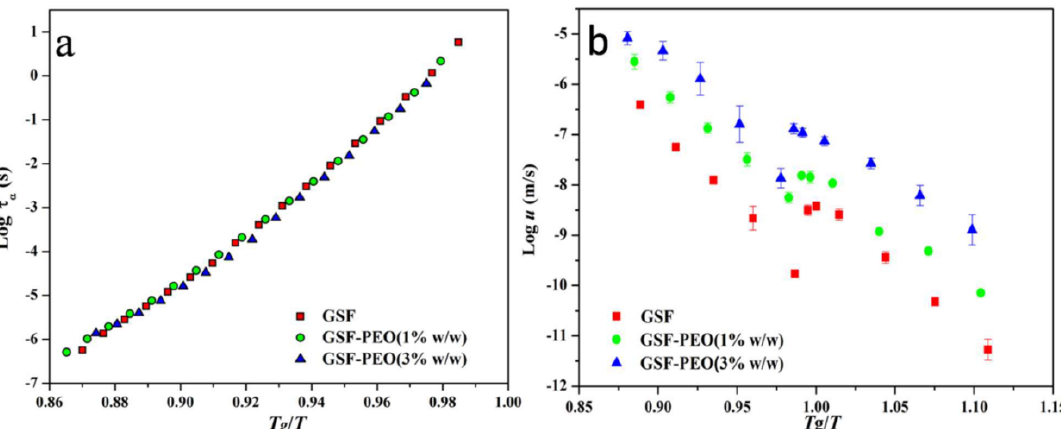
Figure 5. ( a ) Plots of α -relaxation time; ( b ) plots of crystal growth rates on a T g / T scale. Adapted from Ref. [54] with permission. Copyright © 2017 American Chemical Society.